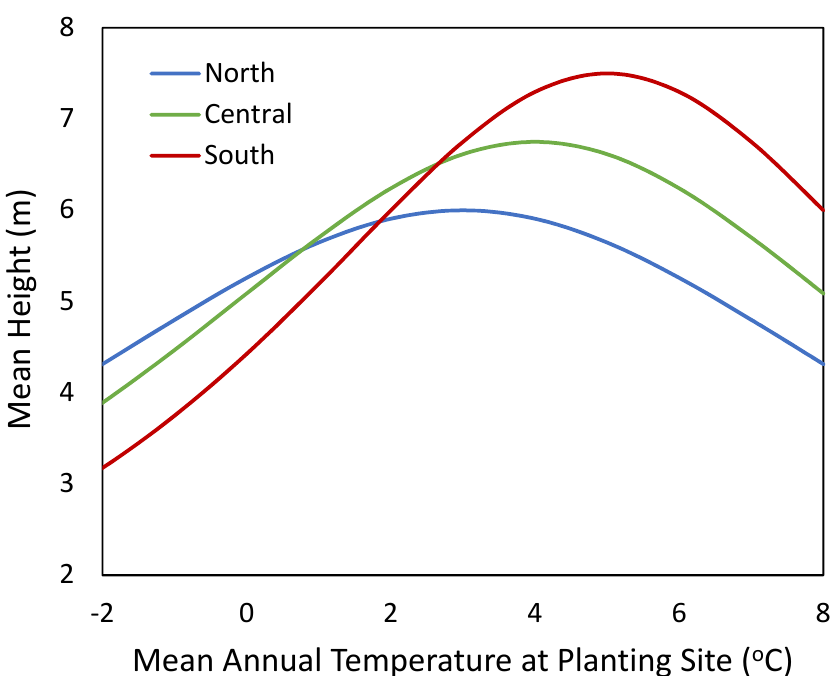
Figure 1. Expected height growth response of northern, central, and southern seed sources along a gradient of mean annual temperature (modified from Pedlar and McKenney [19]).